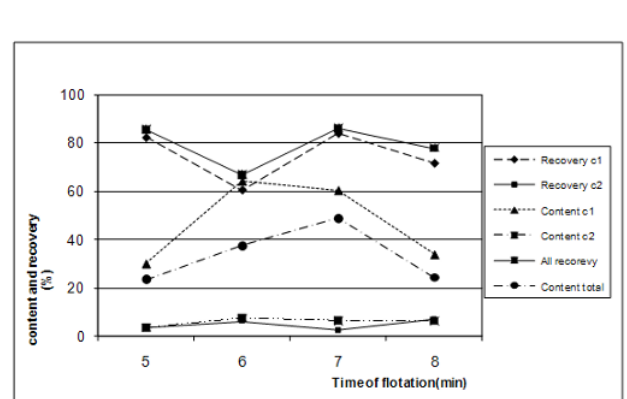
Fig. 6. Curve 6. Content and recovery of